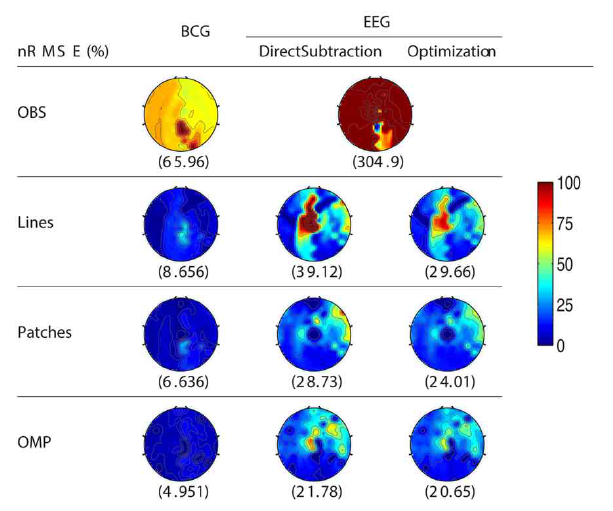
FIGURE 4 | Topographic maps of nRMSE (%) after averaging all cross-validation results. The spatially collective ave nRMSE s(%) over all channels are in the